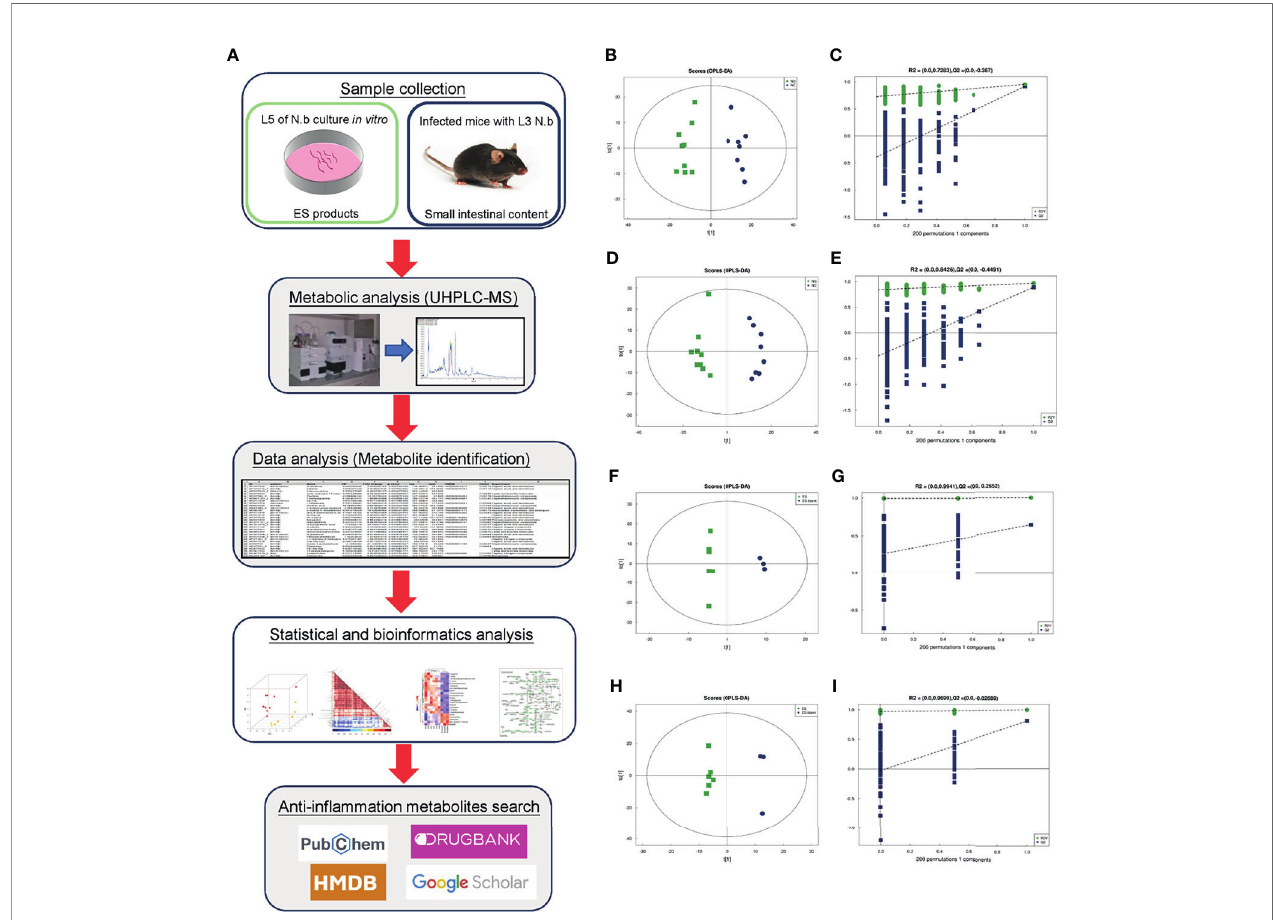
FIGURE 1 | Schematic fl owchart, OPLS-DA score plots, and corresponding permutation tests in positive and negative modes of the present study. Schematic fl owchart of metabolomic analysis for ESPs and intestinal content from Nb-infected mice (A) . The scatter plots of the OPLS-DA score of ion mode: (B, F) positive and (D, H) negative. The results of the permutation test of ion mode: (C, G) positive and (E, I)